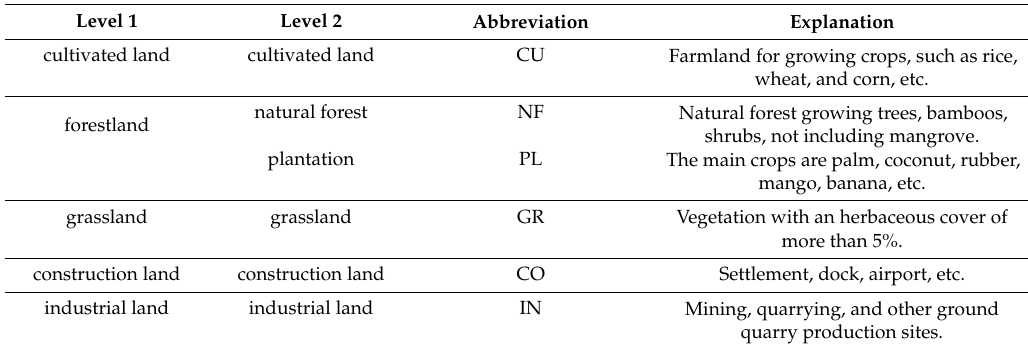
Table 3. Land use categories.